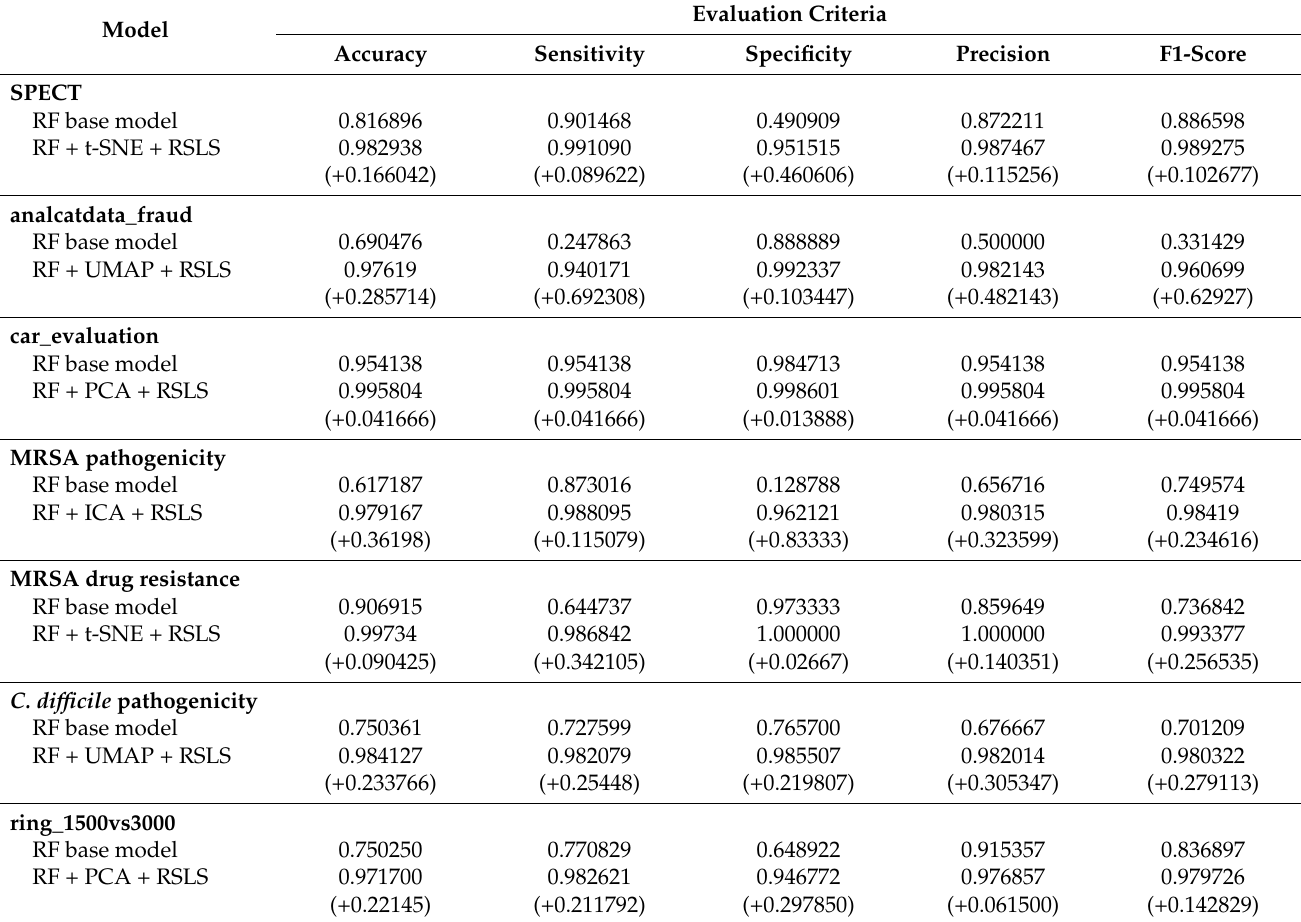
Table 2. Performance metrics of the best combination compared to base model.